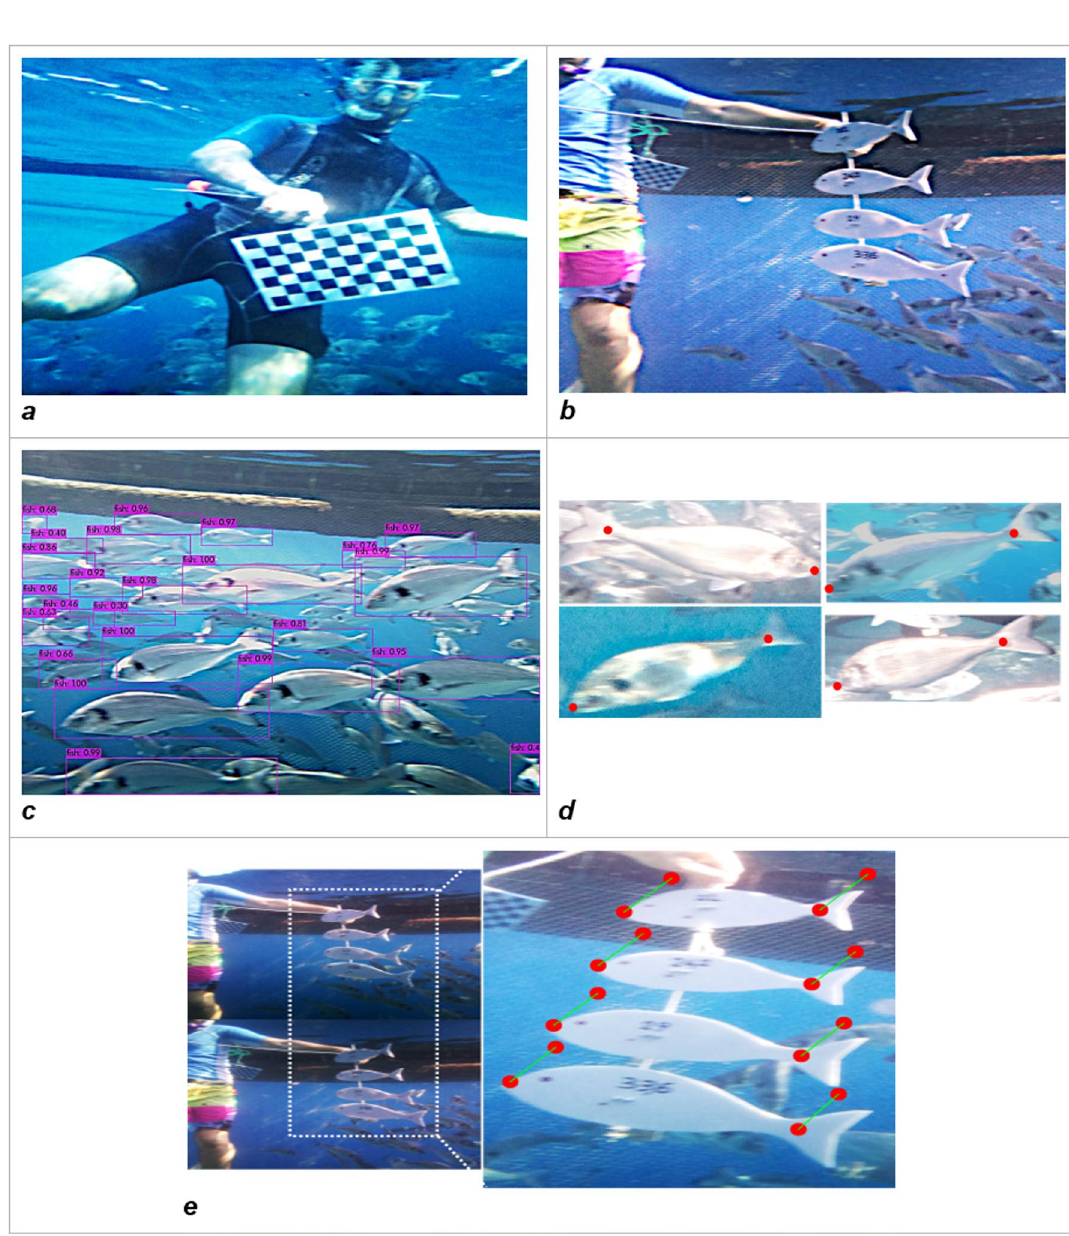
Figure 5. ( a ) Underwater image of the chessboard pattern used for calibration of real pixel size. ( b ) Example of fish silhouettes validation and error estimation in the cage. ( c ) Bounding boxes of automatic annotated fish with confidence thresholds. ( d ) cropped images of single fish and landmarks apposition. ( e ) translation example of fish silhouettes comparing the two stereo-camera images (red dots represent the same landmark from different